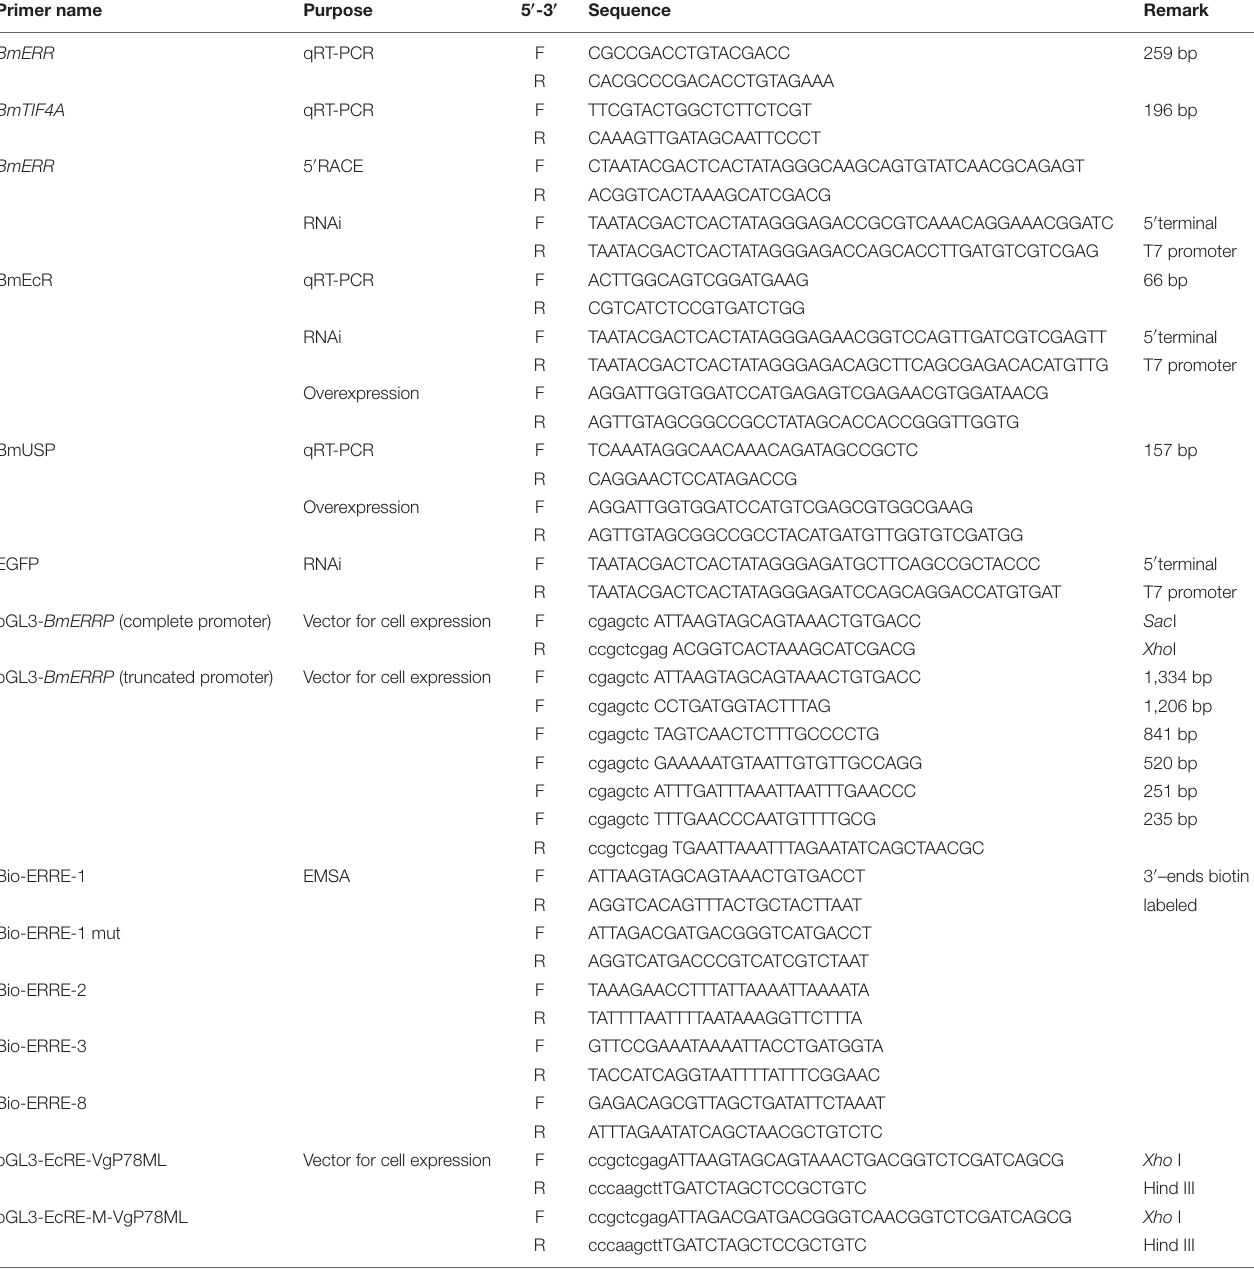
TABLE 1 | Primer for this